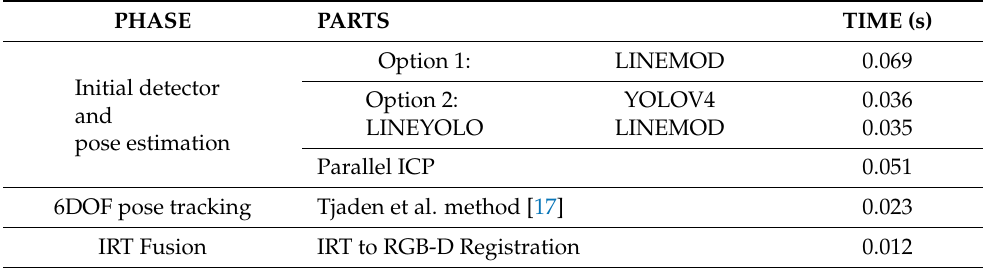
Table 5. Average time (in seconds) of the main methods used in the AR